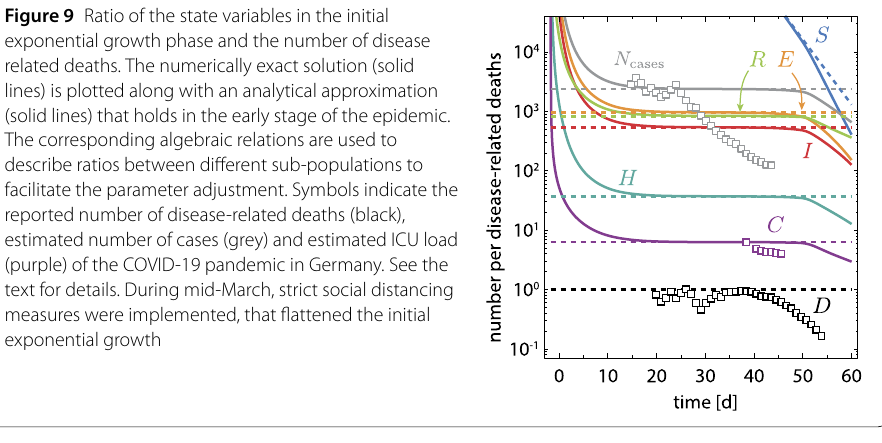
Figure 9 Ratio of the state variables in the initial exponential growth phase and the number of disease related deaths. The numerically exact solution (solid lines) is plotted along with an analytical approximation (solid lines) that holds in the early stage of the epidemic. The corresponding algebraic relations are used to describe ratios between different sub-populations to facilitate the parameter adjustment. Symbols indicate the reported number of disease-related deaths (black), estimated number of cases (grey) and estimated ICU load (purple) of the COVID-19 pandemic in Germany. See the text for details. During mid-March, strict social